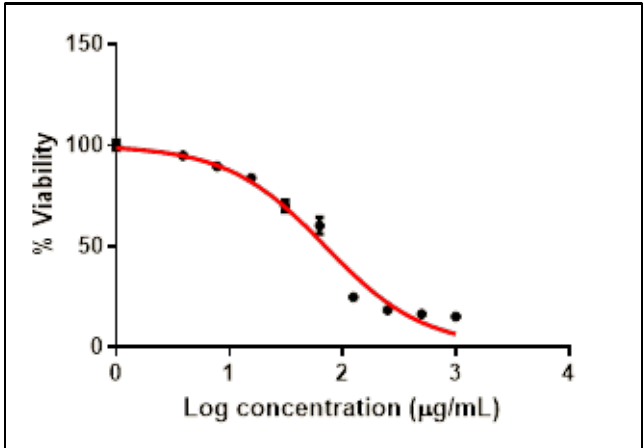
Figure 1. Chromatogram for the identified molecules of SCRE.